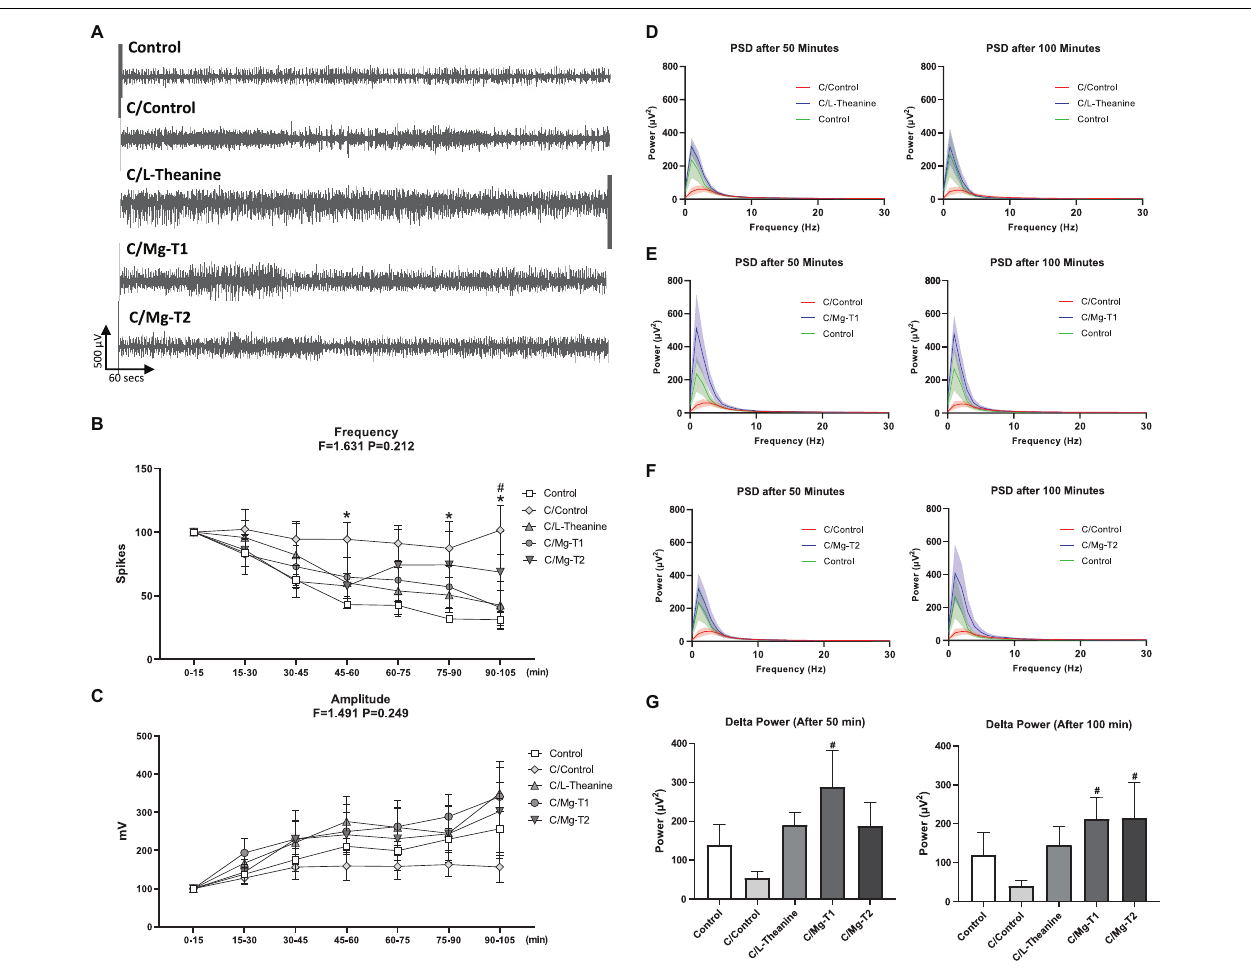
FIGURE 2 | Effect of L -theanine and Mg- L -theanine compounds on brain electrical activity. Representative ECoG recordings for each group (A) and analyses of spike frequency (B) and amplitude (C) on ECoG. Values are represented as mean ± SEM for each group, n = 6. Symbols indicate significance by Fisher’s LSD as * p < 0.05 between Control and C/Control, # p < 0.05 between C/Control and C/Mg-T1 groups. Frequency-power graphs of L -theanine (D) , Mg-T1 (E) , and Mg-T2 (F) at 50th and 100th minutes for 0–30 Hz range show restoration of slow brain waves after caffeine-induced decline which is then separately graphed for comparison of delta power between groups (G) . Average of the 1200 FFTs (10 min following 50th and 100th minutes) were calculated for each animal. # p < 0.05 compared to C/Control group. All values are represented as mean ± SEM.